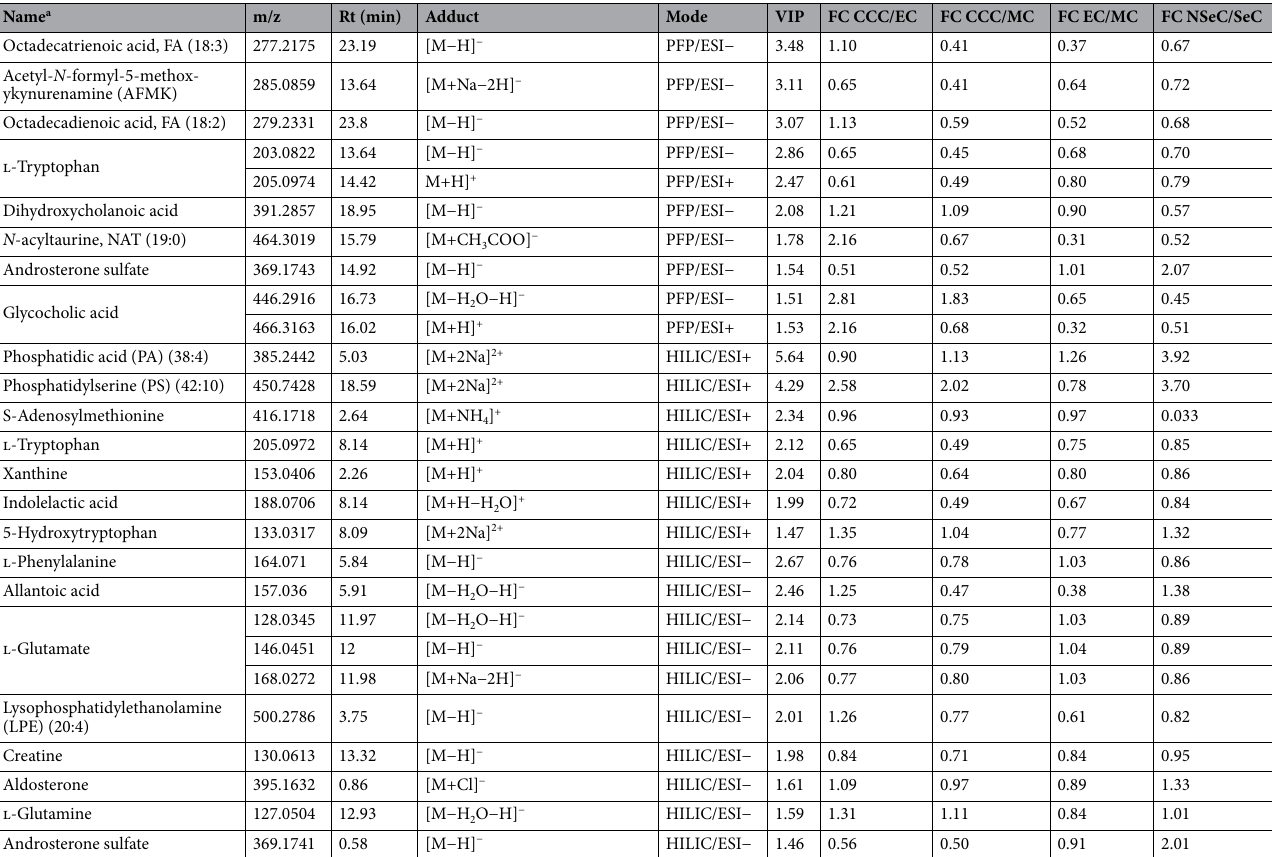
Table 2. Levels of metabolites or lipid species found to be most discriminative for ovarian carcinoma subtype classification. Metabolites/lipids were selected according to VIP values (≥ 1.5) and/or Mann–Whitney test (adjusted p < 0.05) results. Fold changes (FCs) were the ratios of the average MS ion intensities (peak areas) between particular groups studied. CCC – clear cell carcinoma, EC – endometrioid carcinoma, MC – mucinous carcinoma, NSeC, SeC – non-serous and serous ovarian carcinoma, respectively. a Metabolites or lipids were sorted out with decreasing VIP values and data acquisition